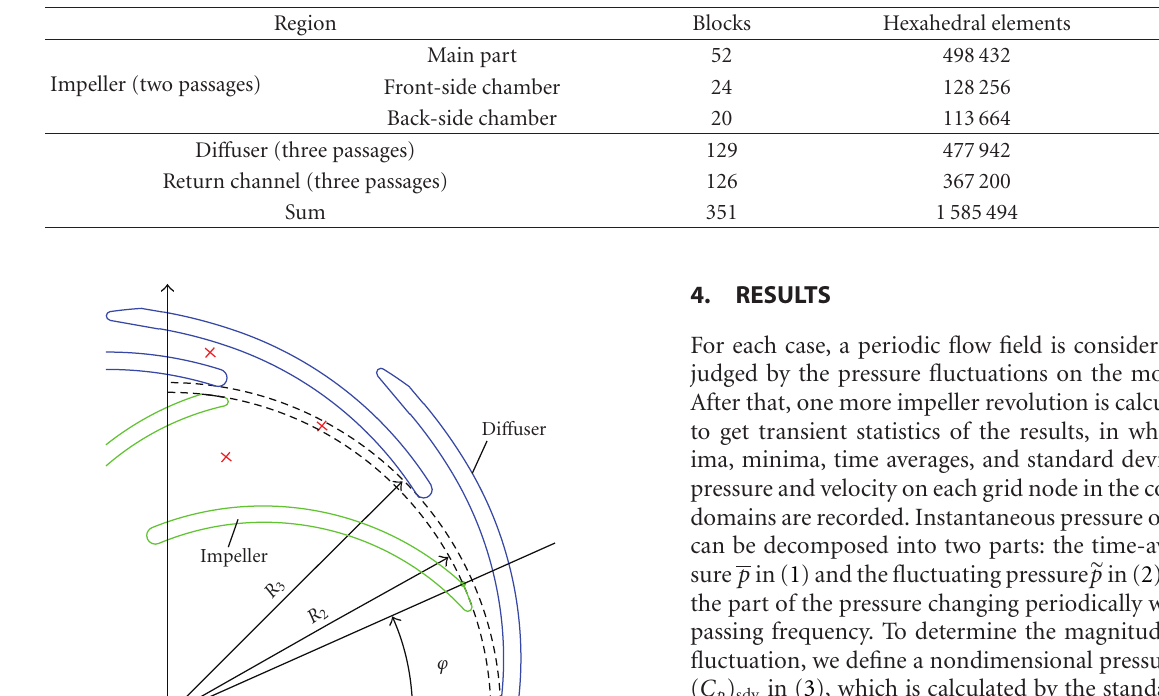
Table 2: Grid information.